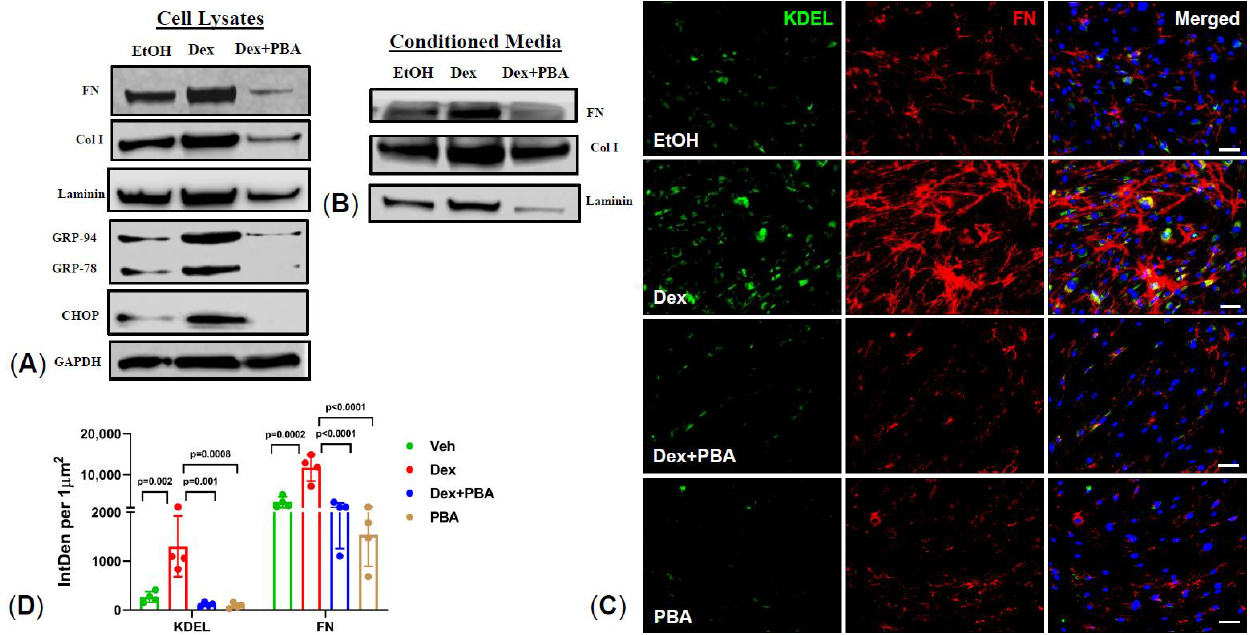
Figure 2. PBA prevents Dex-induced ECM synthesis and ER stress in primary human TM cells: Primary human TM cells were treated with ethanol, Dex (100 nM), and Dex + PBA (5 mM) for 7 d and ECM and ER stress markers were determined in cellular lysates ( A ) and conditioned media ( B ) by Western blotting and immunostaining ( C , D ). Increased levels of ECM (FN, ColI, and laminin) and ER stress (GRP-94, GRP-78, and CHOP) markers were observed in Dex-treated cells, and PBA treatment reduced Dex-induced ECM and ER stress in primary TM cells ( A , B ). Representative immunostaining images of KDEL and FN ( C ), and their intensity measurements ( D ) further confirmed that PBA significantly reduces Dex-induced ER stress and ECM synthesis in primary human TM cells. Data are shown as mean ± SD ( n = 3–4, ONE WAY ANOVA with multiple comparison, scale bar 50 µm).